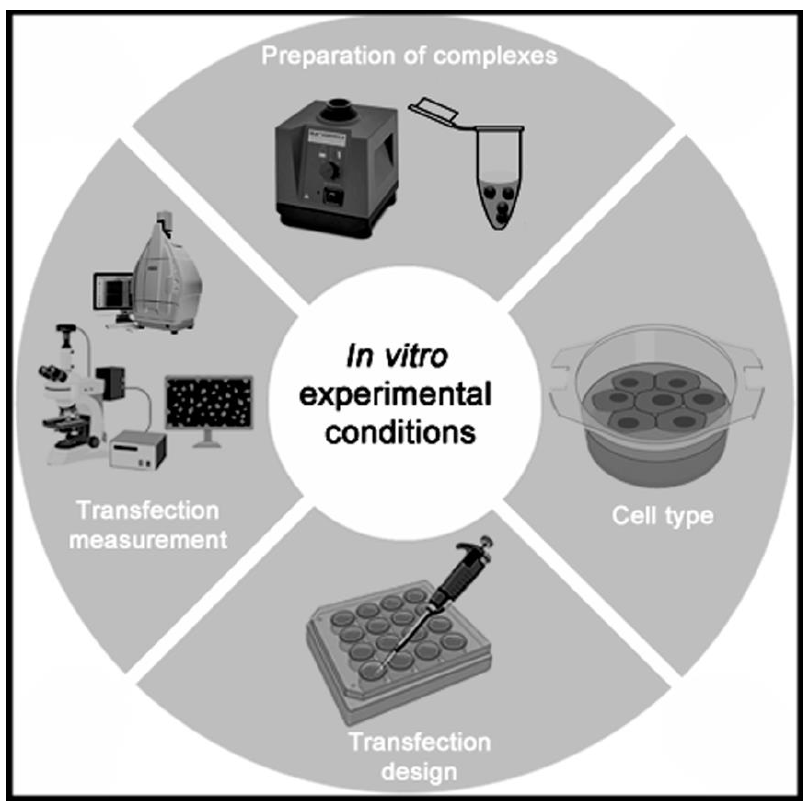
Figure 8. Brief schematic representation of relevant parameters that affect the in vitro performance efficiency of non-viral vectors.